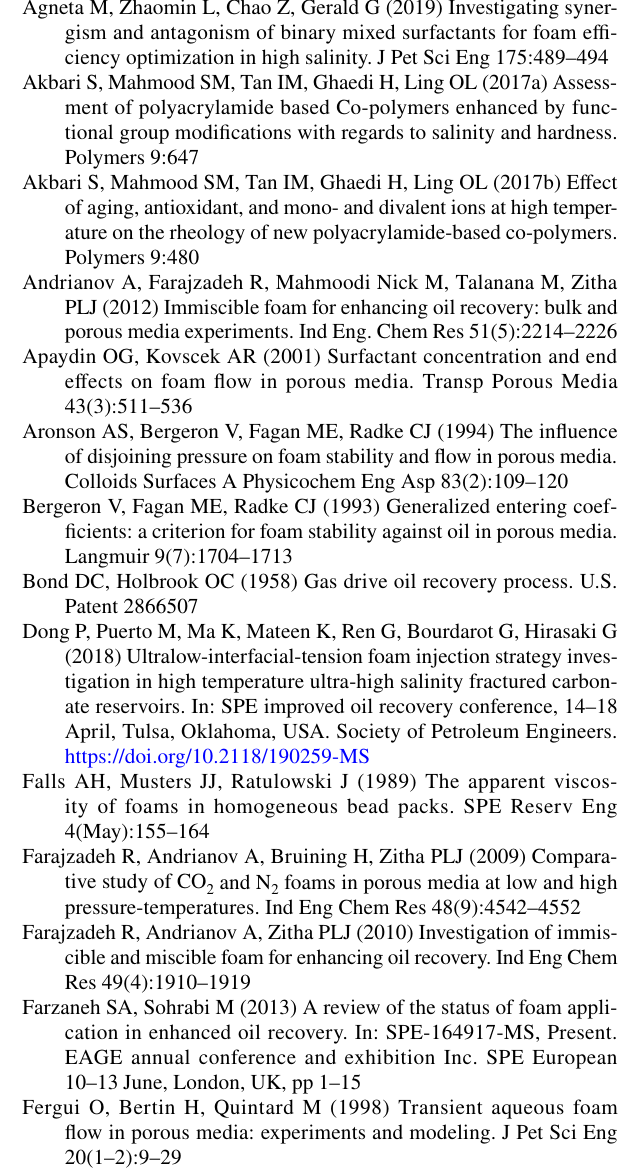
a Best performance, b